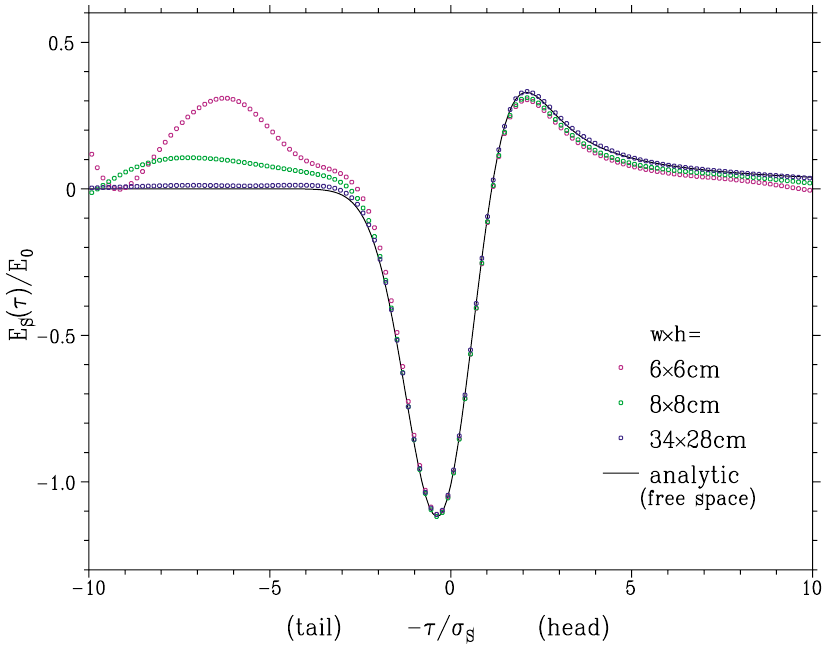
FIG. 1. (Color) The longitudinal electric field E line. The dots are the simulation results for various sizes of the vacuum chamber corresponding to w (cid:10) h (cid:1) 6 (cid:10) 6 cm (magenta), 8 (cid:10) 8 cm (green), and 34 (cid:10) 28 cm (blue), respectively. Length of the magnet is 2.1 m. E